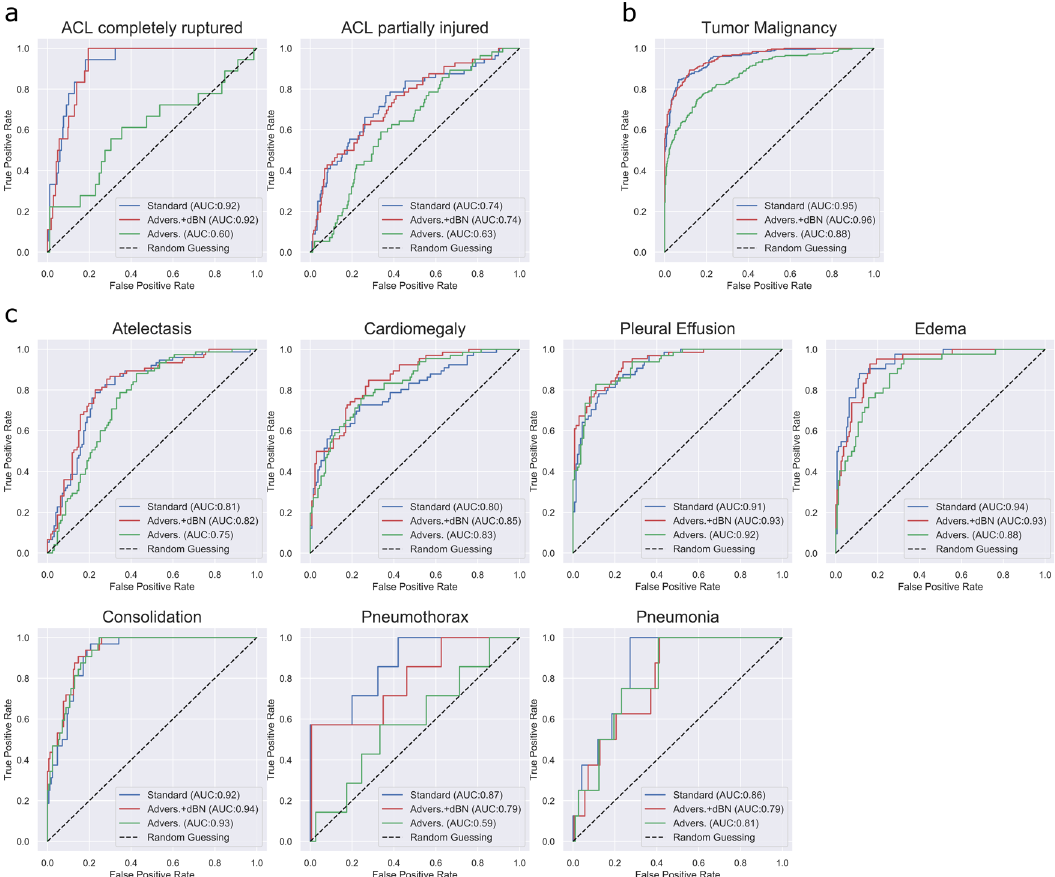
Fig. 2 The usage of dual batch norm boosts the classi fi cation performance of neural networks. Three models were compared: blue: neural network without adversarial training, green: neural network with adversarial training and red: neural network with adversarial training employing dual batch norms. The models' performances were tested on three distinct datasets: a Rijeka knee magnetic resonance imaging (MRI) dataset. b Luna16 dataset containing computed tomography (CT) slices of malignant tumors and ( c ) CheXPert thoracic X-ray dataset. We found that robustness and good performance appear to be incompatible when data is limited. In both experiments ( a and b ), the AUC of naively adversarially trained models (green) dropped signi fi cantly as compared to models trained in a standard fashion (blue). However that performance gap was reduced when the models were trained on a large dataset of 191,027 radiographs ( c ). Adversarially trained models performed best when employing dual batch norm (red), no signi fi cant difference in performance to the naively trained models were found. As re fl ected by the red curves, the performance of robust models was boosted across different datasets when dual batch norm training was employed ( a – c